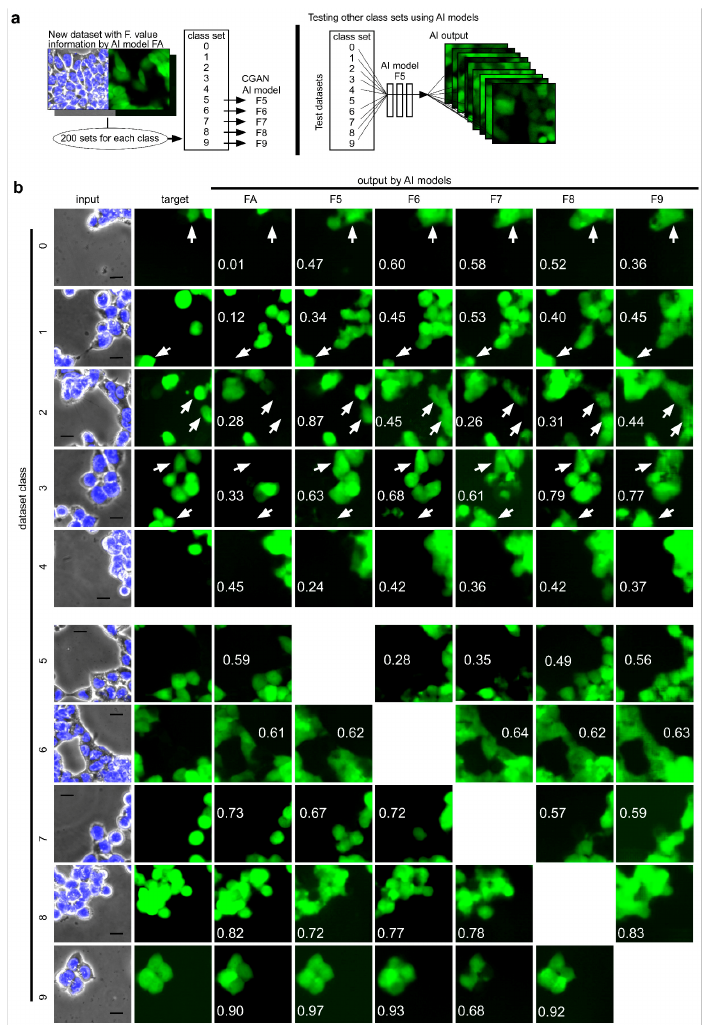
Figure 4. Comparison of output CSC images depicted by AI models trained using images with the same class of F-measure values. ( a ) A scheme of dataset preparation for training and testing the AI model. The new dataset included 28,672 pairs with F-measure values that were obtained using the AI model trained with 7168 pairs (AI model FA). The class set included 200 pairs that were selected by F-measure value. AI models F5–6 were trained with F-measures specifically; ( b ) CSC image depicted from a Hoechst 33342-overlaid phase-contrast image. The input with various F-measure values was tested for the output using various AI models. Arrows were placed for visual assistance of comparison between outputs. Numbers in the output represent the F-measure value calculated using target and output images. Scale bars = 50 µ